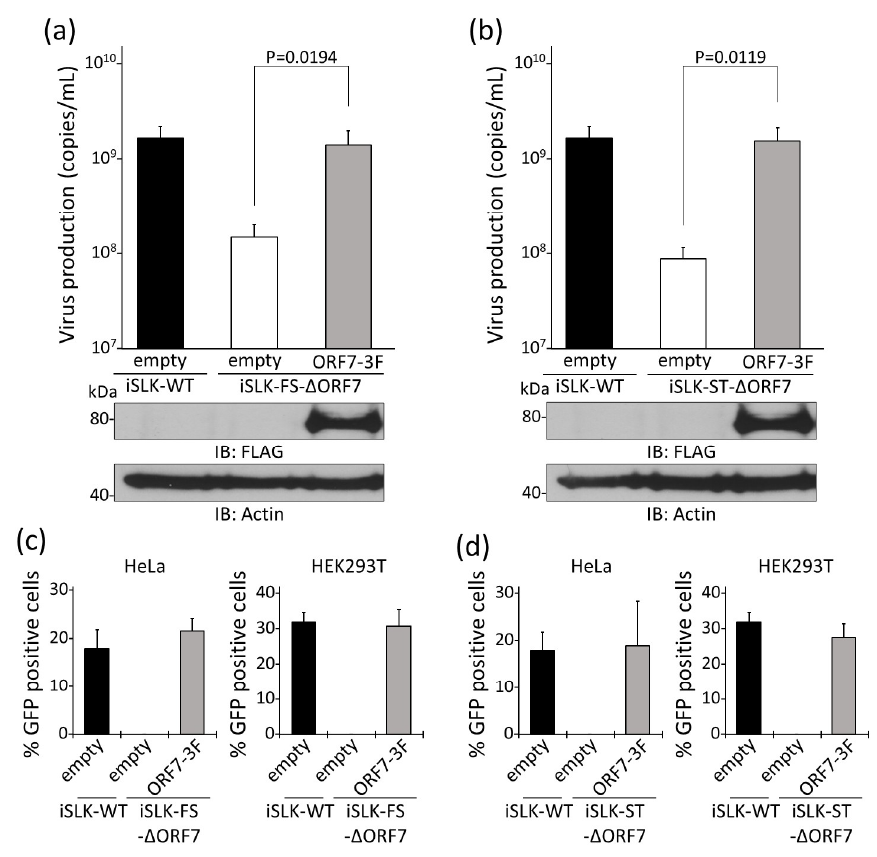
Figure 3. Virus production in iSLK cells harboring ORF7-deficient KSHV was recovered by exogenous ORF7 expression. Rescue of virus production in iSLK-FS ∆ ORF7 cells ( a ) and iSLK-ST ∆ ORF7 cells ( b ) by exogenous ORF7 expression. iSLK-FS ∆ ORF7 or iSLK-ST ∆ ORF7 cells were transiently transfected with ORF7-3xFLAG plasmid (or empty plasmid) and simultaneously cultured with medium containing Dox and NaB for 72 h. At 72 h after treatment and transfection, levels of KSHV genome copies of KSHV virions in culture supernatants were determined using real-time PCR. Exogenous ORF7 expression in ORF7-3xFLAG-transfected and Dox-induced iSLK cells was confirmed by Western blotting using anti-FLAG antibody. Original images of the Western blotting are shown in Supplementary Figure S2. ( c , d ) Evaluation of infectious virion in culture supernatants of ORF7-3xFLAG-transfected iSLK-FS ∆ ORF7 cells ( c ) and iSLK-ST ∆ ORF7 cells ( d ). At 72 h after Dox treatment and transfection, collected culture supernatants were inoculated with HeLa and HEK293T cells for infection. At 72 h post-infection, GFP-positive cells were counted by fluorescence microscopy. ( a – d ) “empty” and “ORF7-3F” mean the empty plasmid and ORF7-3xFLAG plasmid,